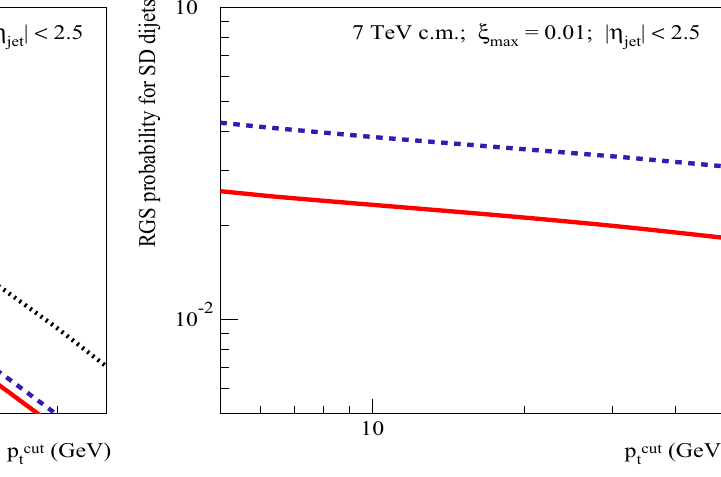
√ s = 7 TeV and ξ max = 0 . 01